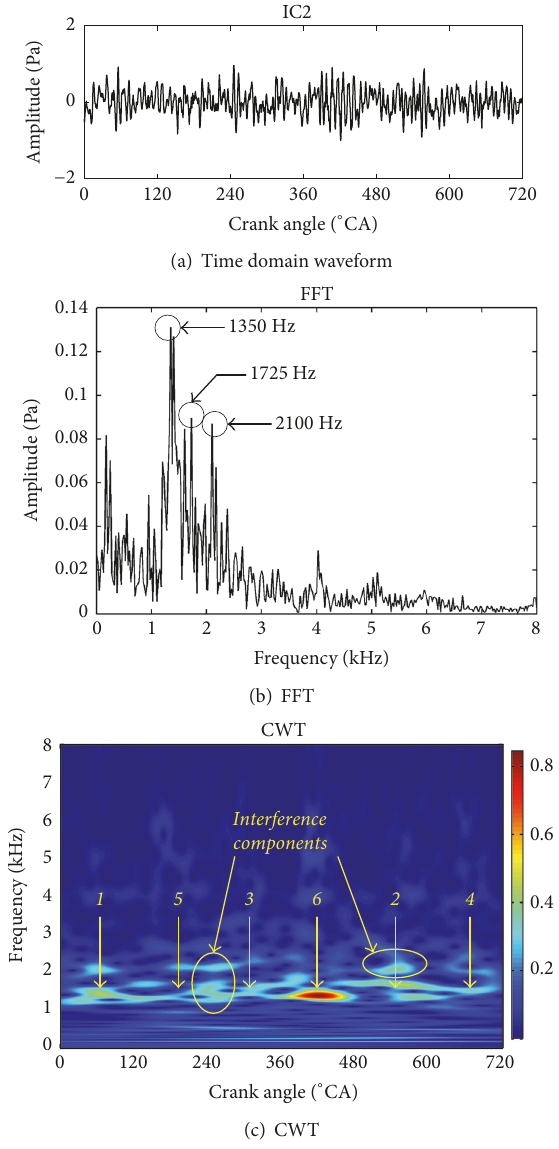
Figure 22: Time domain waveform, FFT, and CWT of IC2 by the EWT-RobustICA method.